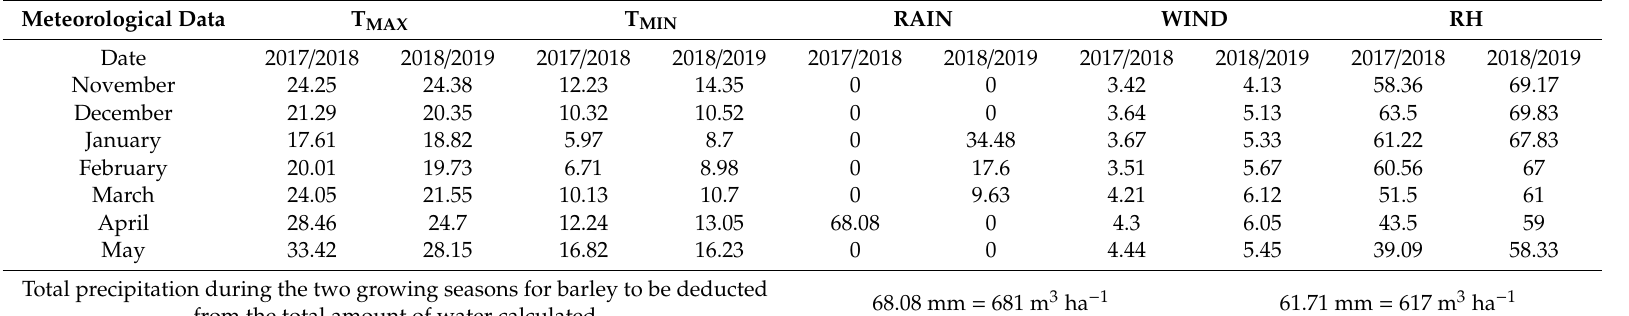
Table 1. Meteorological data for the research farm of the National Research Center (NRC) in Nubaryia. Meteorological